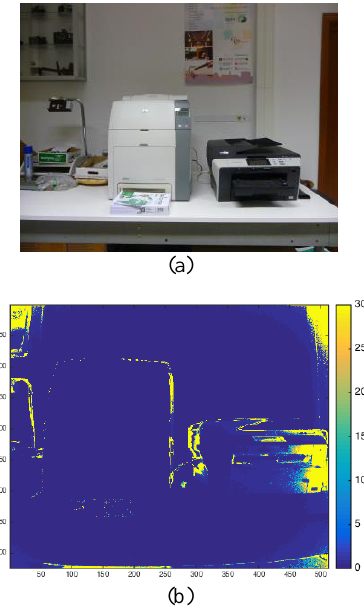
Figure 3. (a) Acquired scene; (b) Standard deviations calculated for each pixel of 100 successive depthmaps (colorbar in cm)